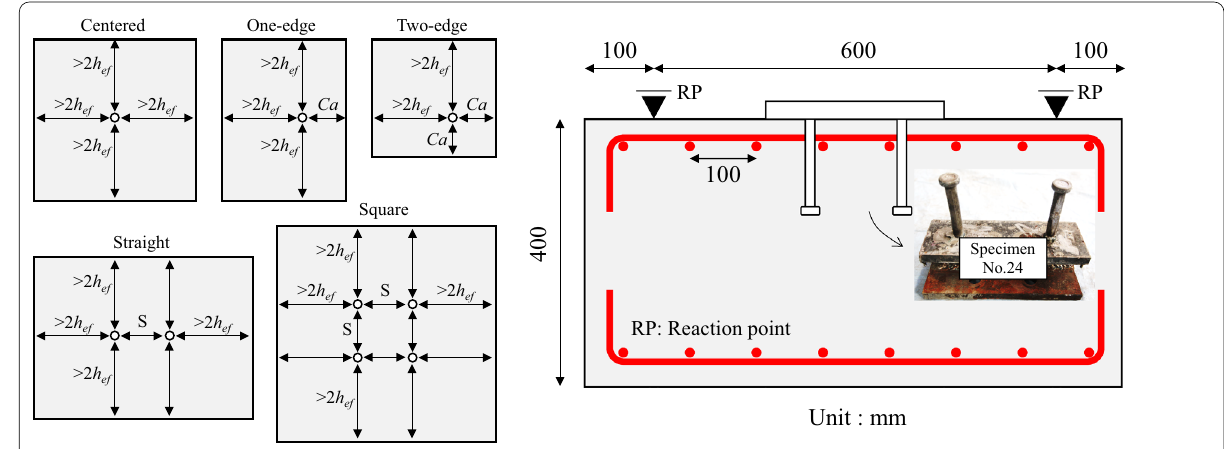
Fig. 3 Specimen design